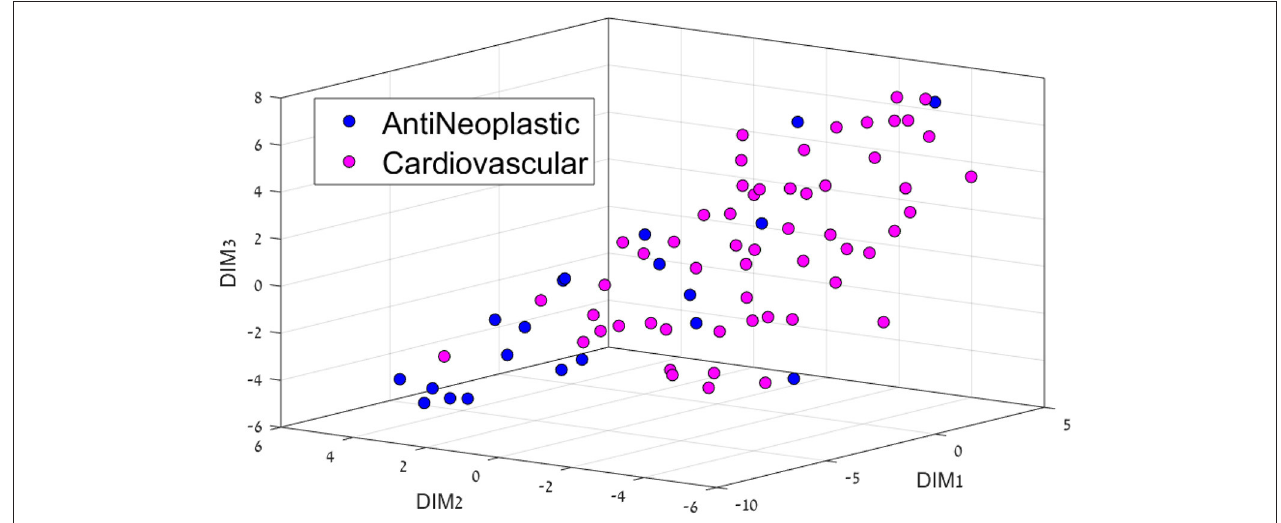
FIGURE 3 | 3D representation of the Anti-Neoplastic-Cardiovascular feature space using the t-SNE algorithm for dimension reduction.